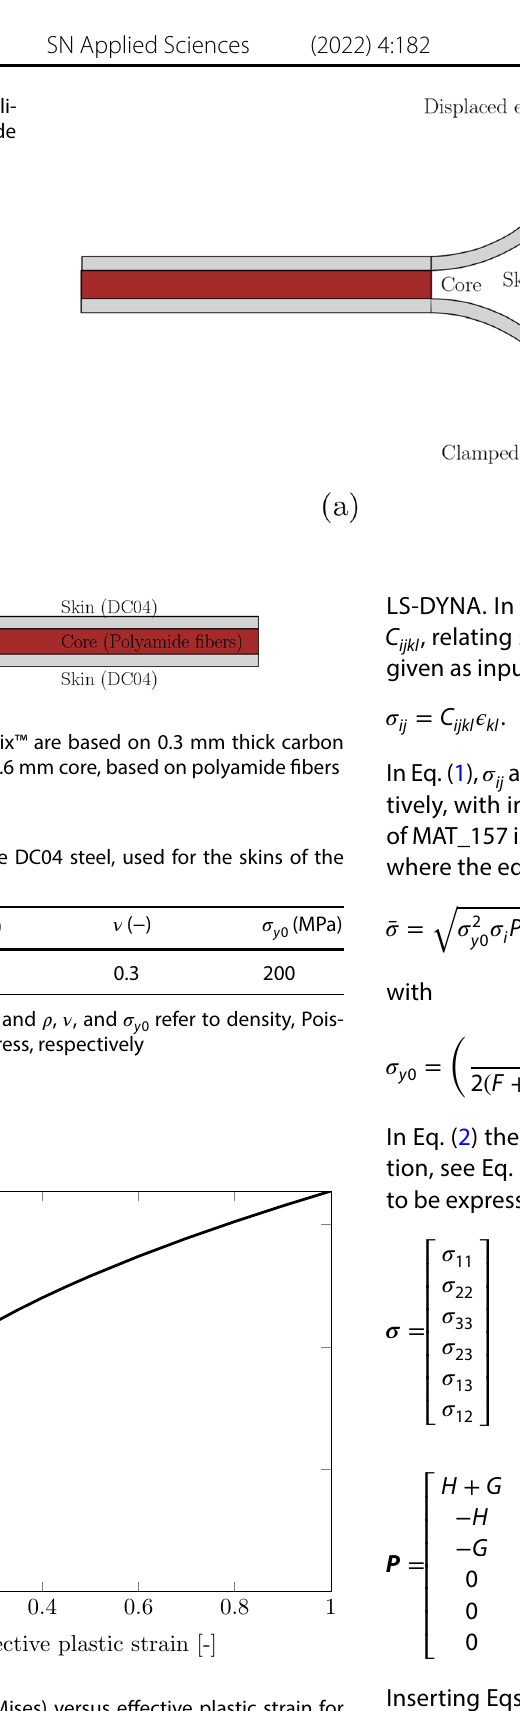
Fig. 5 Effective stress (von Mises) versus effective plastic strain for the skin material